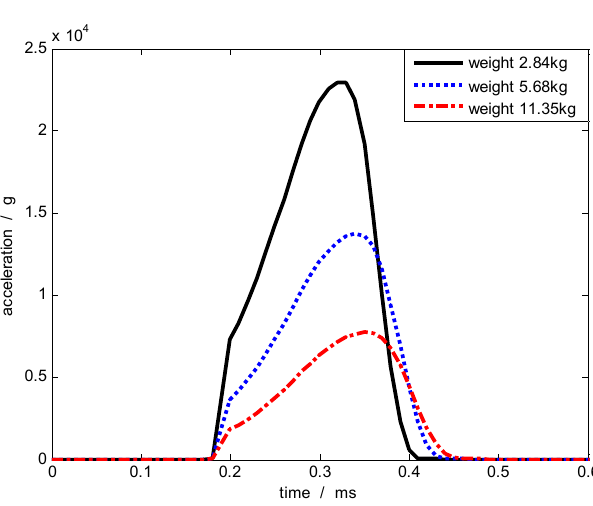
Figure 8. Acceleration pulse generated at the same projectile velocity but with different masses of the impacted body (diameter of the contact surface: 50 mm).